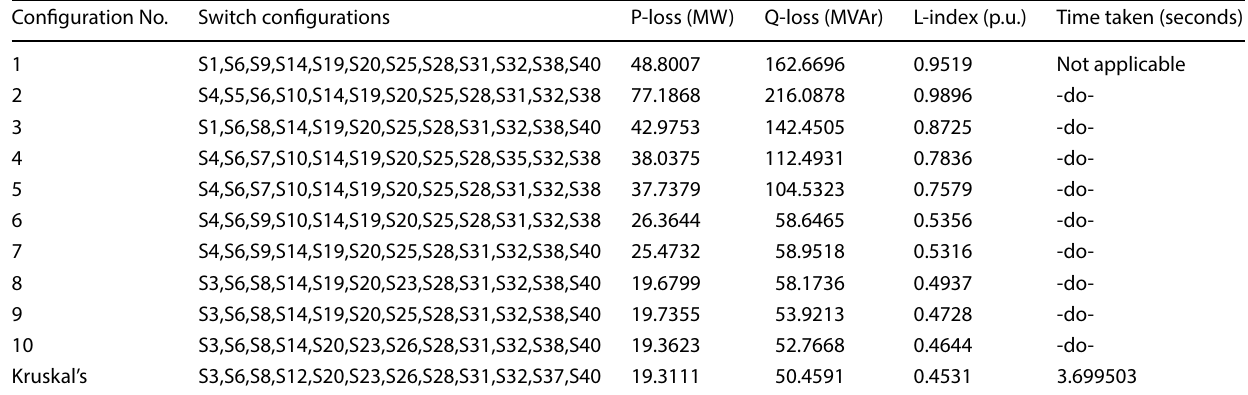
Table 4 Calculated values of L-index, P-loss, and Q-loss at 90% of base load Configuration